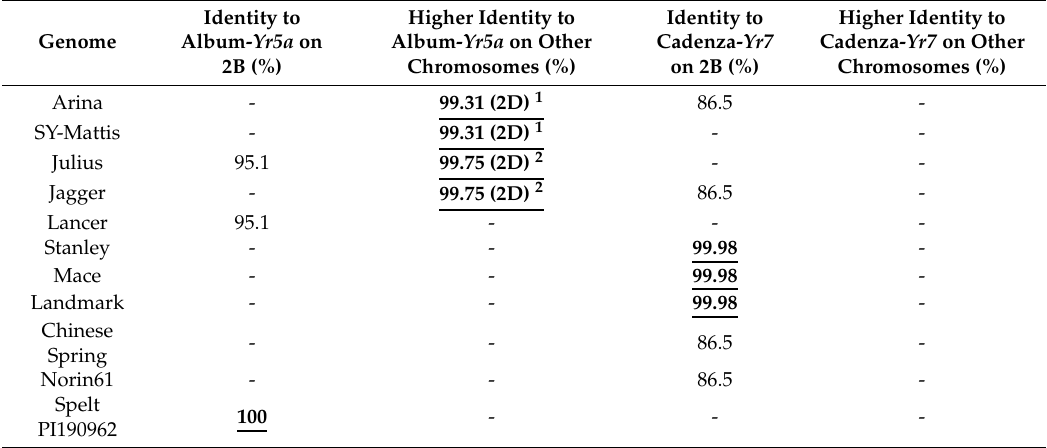
Table 2. In silico allele mining for Cadenza- Yr7 and Album- Yr5a in the ten chromosome-quality wheat